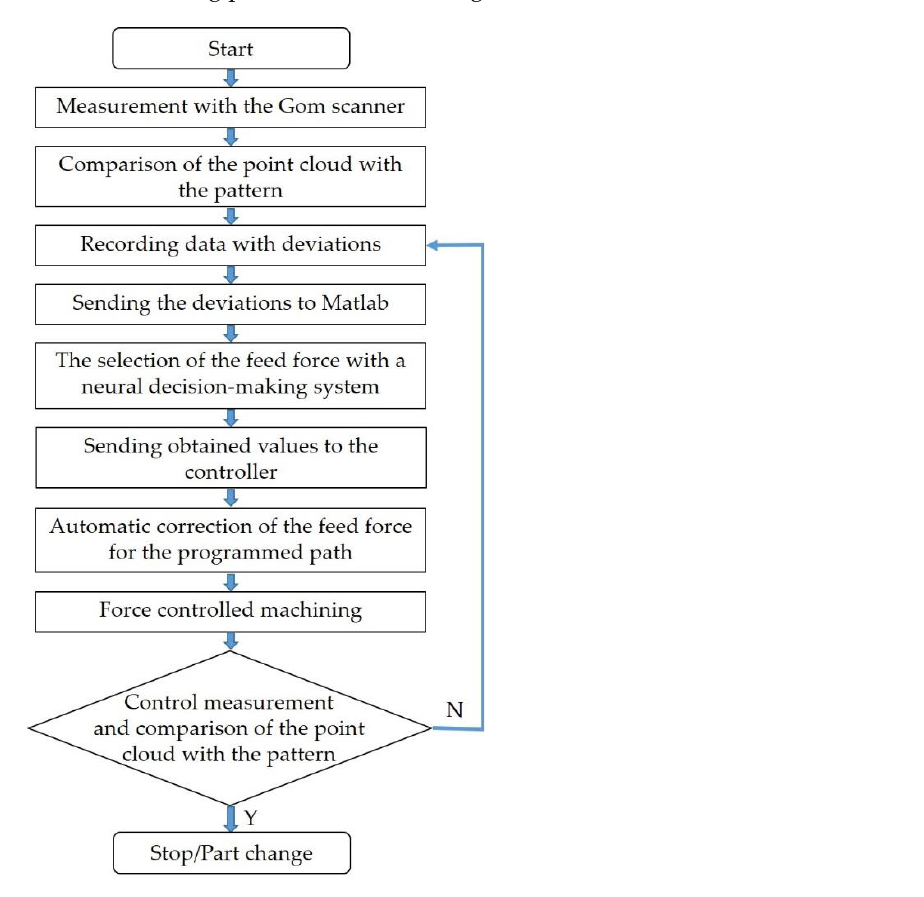
Figure 16. Information flow algorithm in robotic processing in correlation with a 3D scanner and a neural decision-making system.